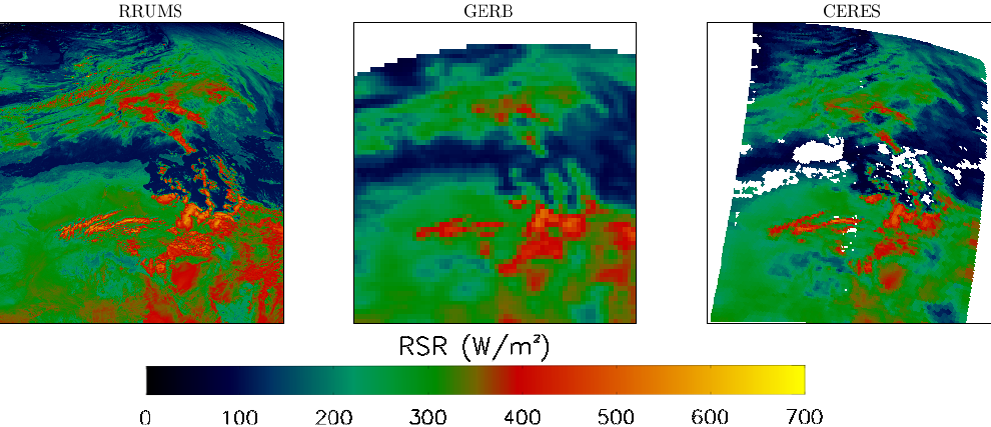
Fig. 9. Comparison between the SW measured irradiances (GERB and CERES) and the RRUMS retrieval. The white areas in all plots are due either to the instrument characteristics or to the method constraints. The corresponding RGB false colour composite can be seen in Fig. 7. Date: 1 January 2007, 10:00UTC Table 3. Comparison between SEVIRI-based RRUMS retrieval and CERES measurements. Bias and standard deviation in Wm − 2 . Date Overpass time (UTC) OLR (LW) RSR (SW) 2004 SEVIRI CERES r Slope Std. dev. Bias r Slope Std. dev. bias